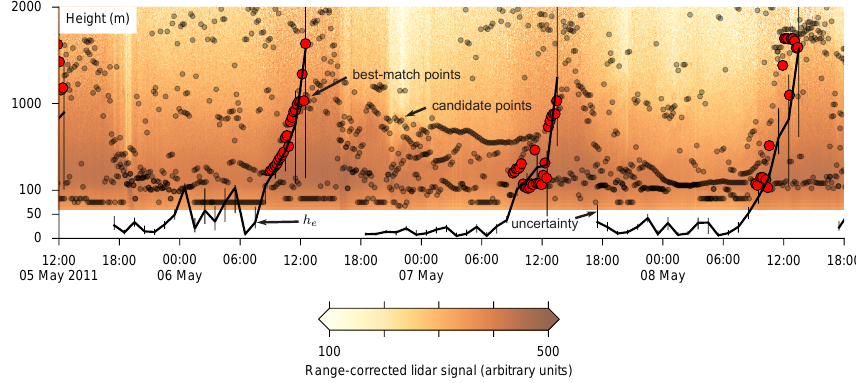
Fig. 5. Lidar-derived and radon-derived mixing estimates over three days. Candidate mixing heights are detected from local gradients in lidar backscatter (which is indicated here with shading), and a best estimate of the mixing height is selected by scaling the radon-derived mixing height, h e , from the box model, and looking for the set of candidate points which lead to the best match. The uncertainty in h e , indicated by vertical bars, is plotted at the the 15th and 85th percentiles, and the y-axis is magnified 5 × below